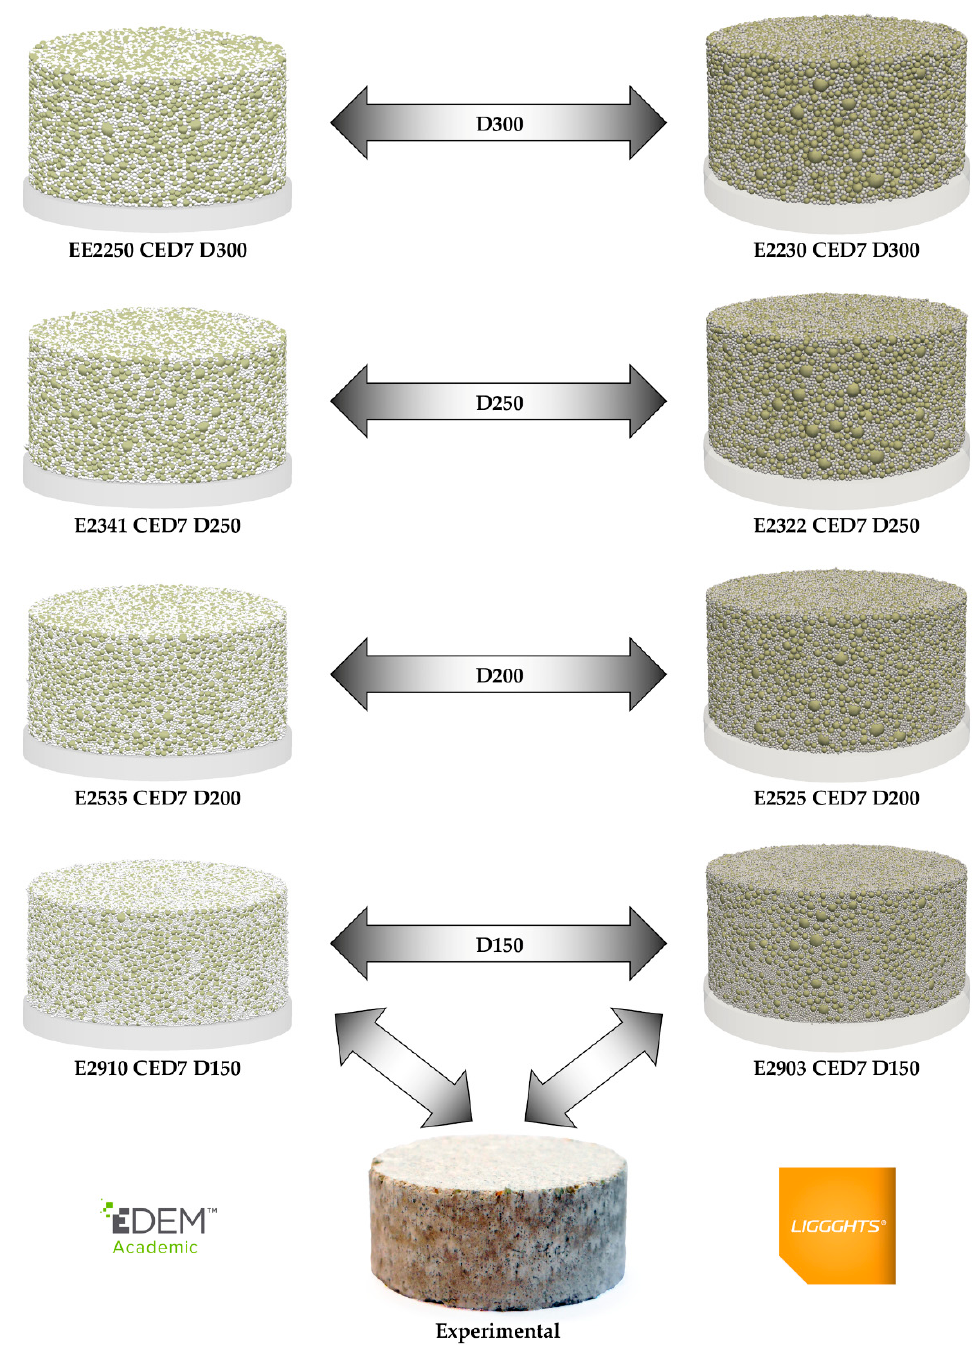
Figure 7. Green compacts obtained in the simulations used to validate the DEM models and real green